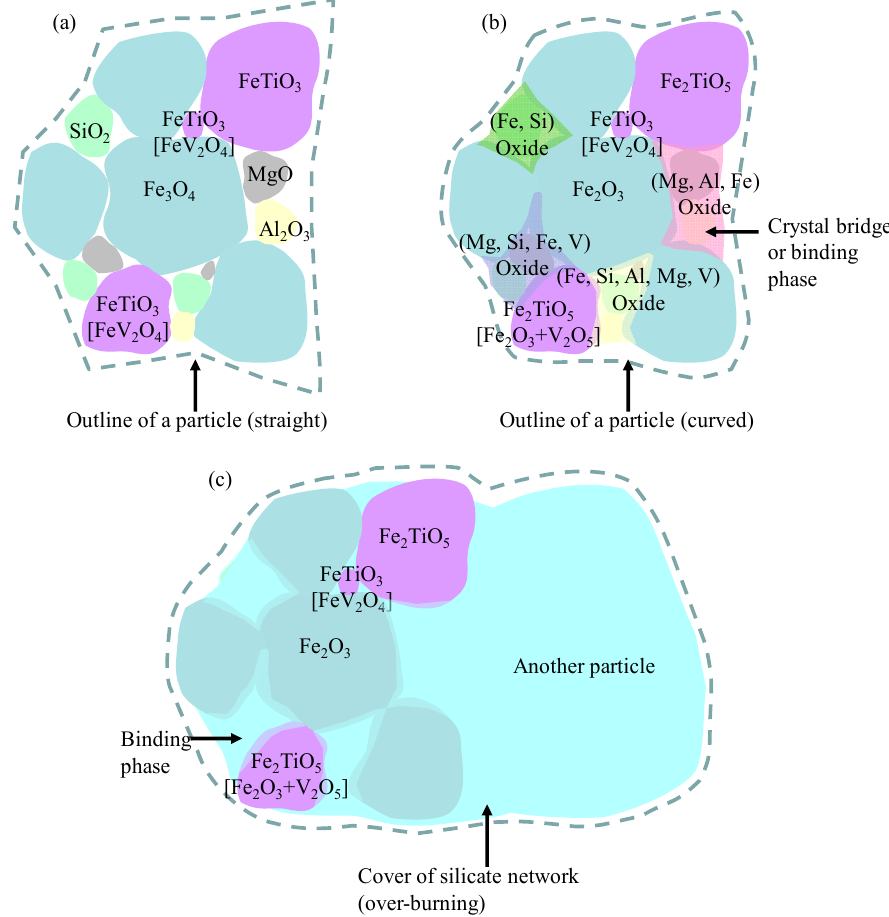
Figure 10. The schematic diagrams of phase transformation behavior of the samples: ( a ) A particle before roasting; ( b ) A particle after roasting (800–1200 °C); ( c ) Aggregation and sinter of two particles after roasting (1250 °C).